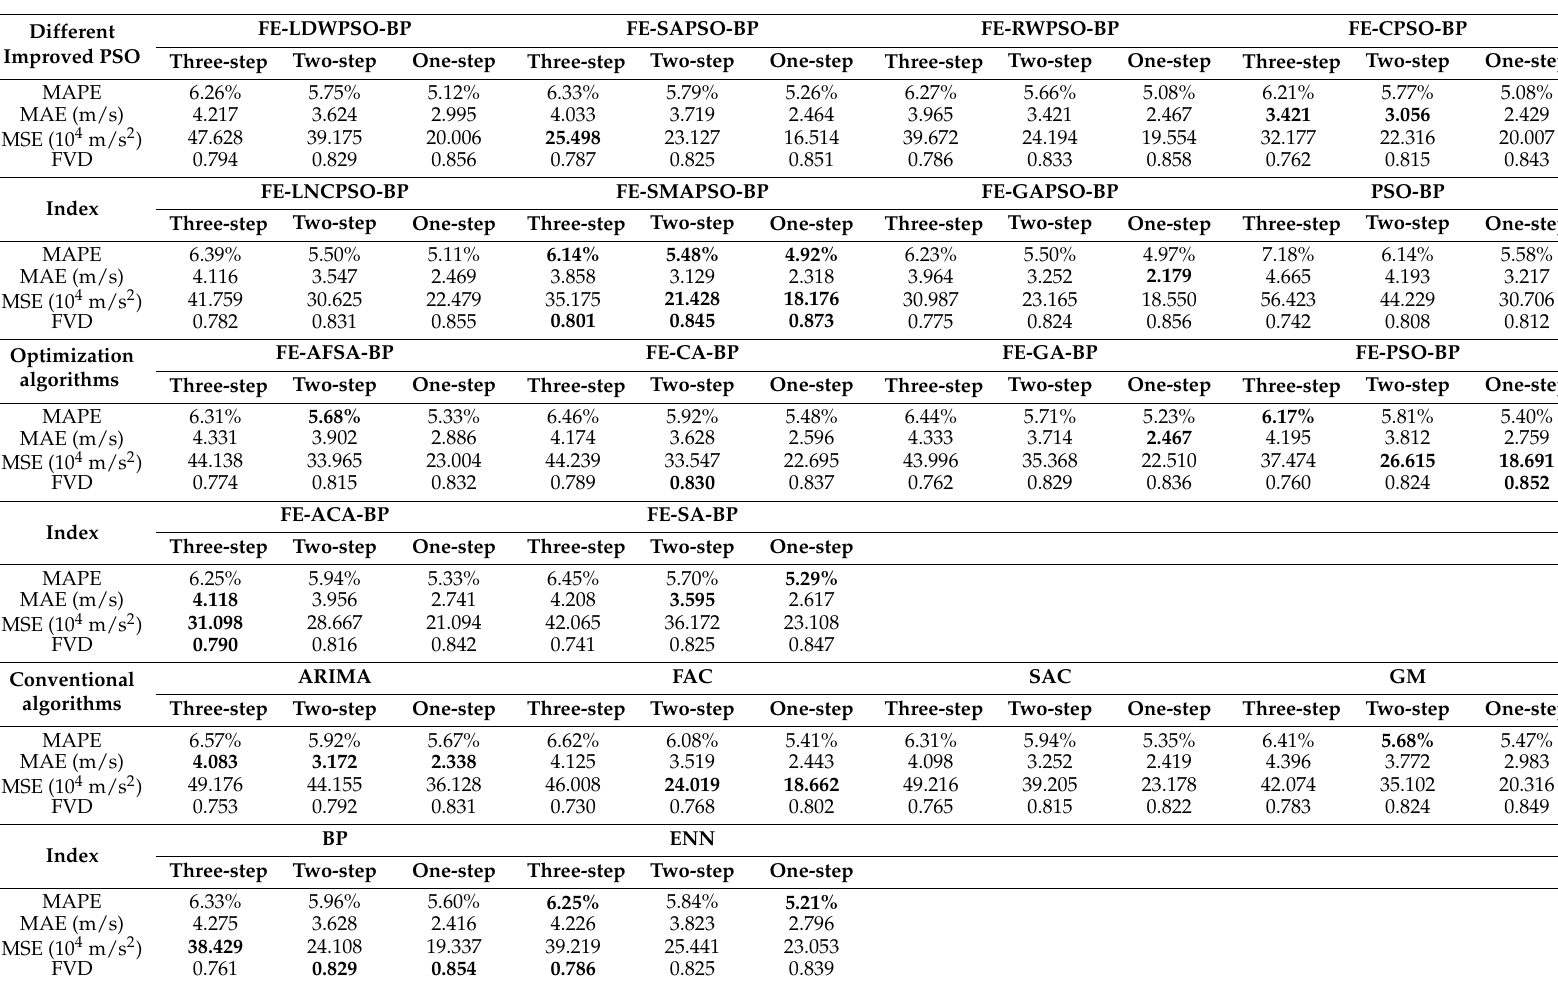
Table 5. Comparison of hybrid models with different optimization algorithms and conventional models for electricity price time